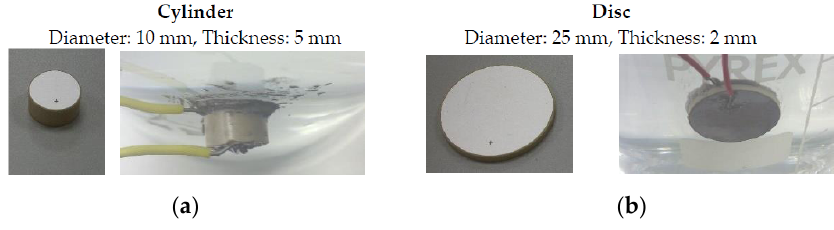
Figure 8. Pictures of the reference cylindrical ( a ) and disc ( b ) ceramics, free and attached to the vessel.